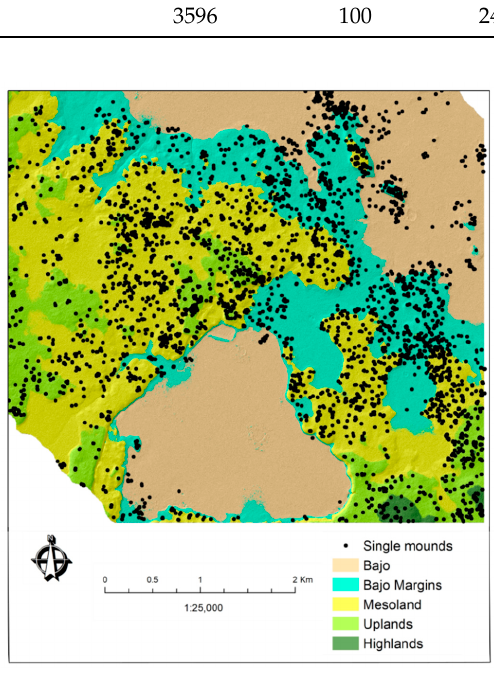
Figure 8. Mound distribution of Yaxnohcah on topographic zones.